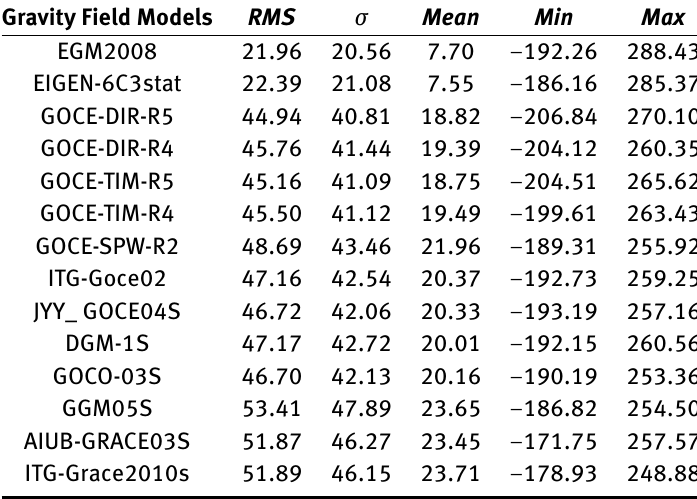
Table 3: Statistics of the comparison between gravity anomalies based on global gravity models and a data set of 8998 free-air gravity anomalies over Greece. Maximum degree of its model is considered. Unit is